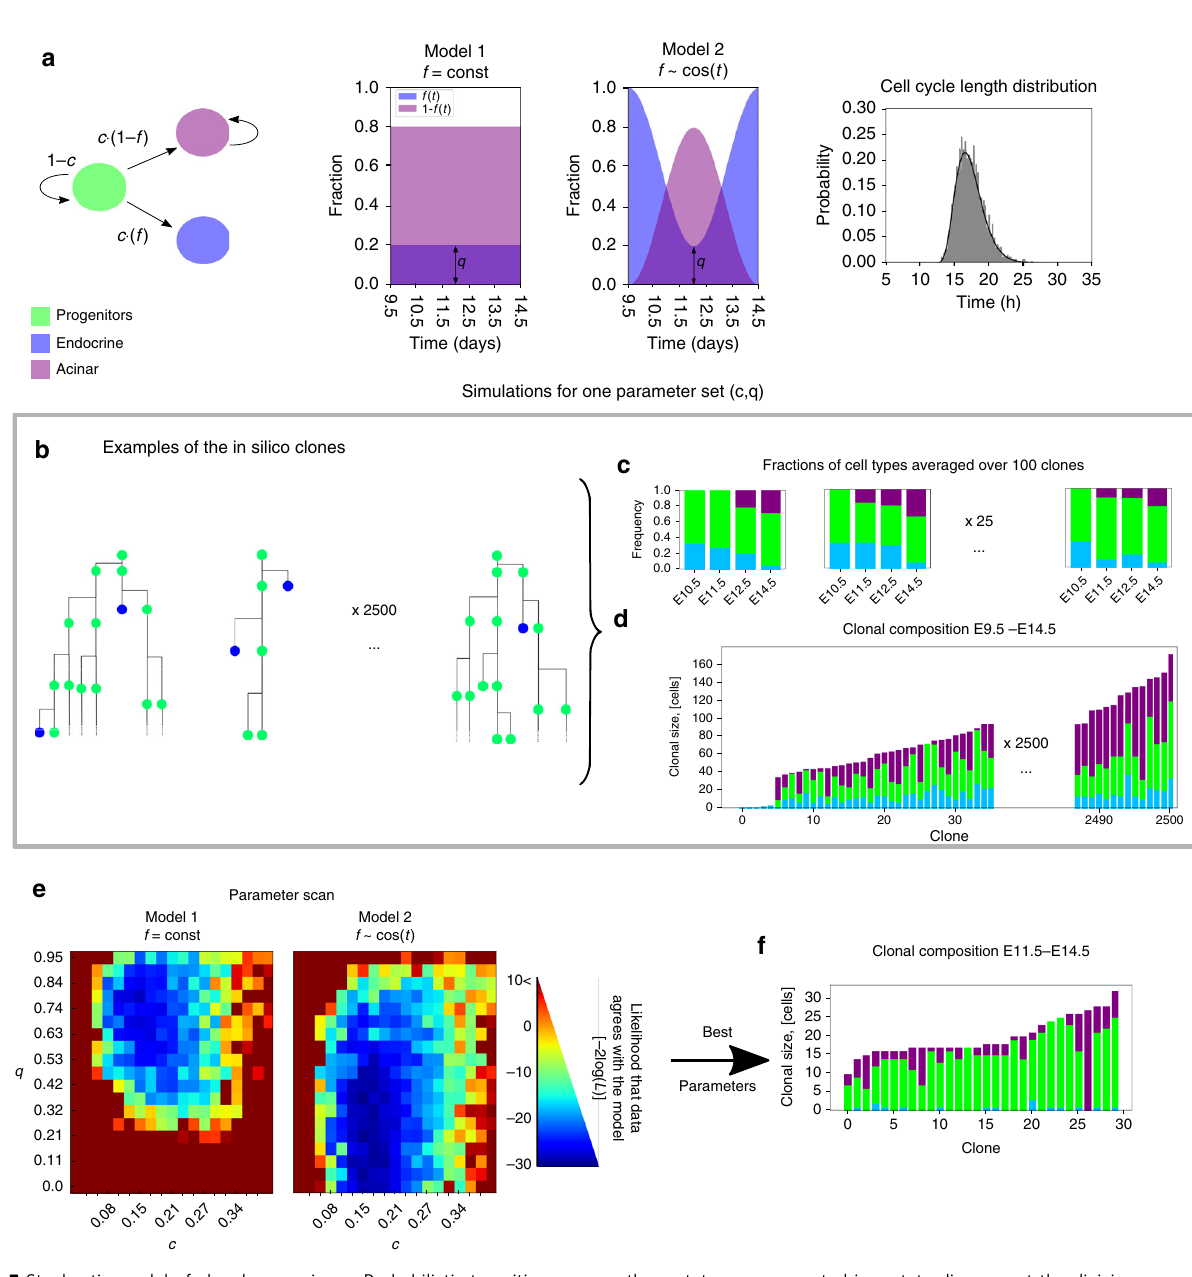
Fig. 5 Stochastic model of clonal expansion. a Probabilistic transitions among three states are presented in a state diagram: at the division progenitors ( green ) differentiate with probability c and maintain progentor state with probability 1 − c . When differentiating, they become endocrine ( blue ) with probability f and acinar ( purple ) with probability 1 − f . We compare two models: in Model 1 the probability f is constant between E9.5 and E14.5, and in Model 2 f is time-dependent and has a minmum at around E12. The height of the minimum is characterised by parameter q. In Model 1 f = g . See Methods for the exact functional form of f for Model 2. While acinar cells continue replicating, endocrine cells are assumed not to replicate. For all replicating cells the cell-cycle lengths are drawn from the gamma distribtuion from 19 (right panel). For every parameter set both models were simulated 2500 times. b Examples of the in silico clonal lineages. c Fraction of cell types from individual clones at E9.5, 11.5, 12.5 and 14.5 (corresponds to experimental data in Supplementary Fig. 7d). d Clonal composition at E14.5 (corresponds to Figs. 1h and 4f). e For each of the parameter sets c , q we estimate the likelihood of the model fi tting the data (See Methods and Supplementary Figs. 8 – 10). The results of the parameter scan are quanti fi ed by the log-likelihood, − 2log( L ). Parameter scans show that Model 2, where the differention of acinar cells and endocrine cells change with time, is more likely. Using Akaike Information Criteria score, AIC, we fi nd that Model 2 is better at describing the data (AIC 1 = − 14.5 and AIC 2 = − 22.1). The probability that the two models are equally good is p = 0.02. f The model predicts that if clonal anlyses are started at E11.5 – 12 instead of E9.5, it becomes more likely to observe lineages